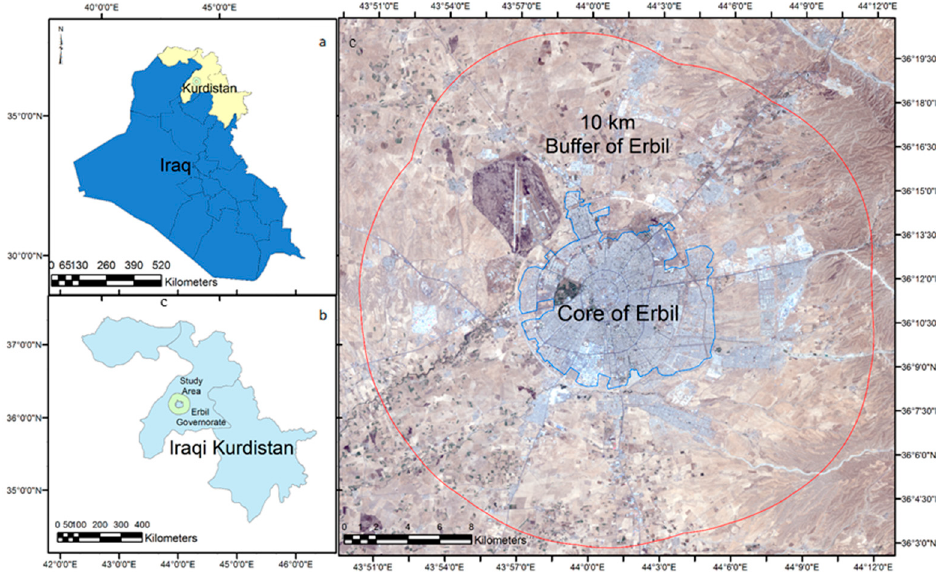
Figure 1. Map of Iraq, the Kurdistan Region and true colour Landsat image of the study area. ( a ) Iraq’s map; ( b ) Kurdistan Regional Government; ( c ) the study area.